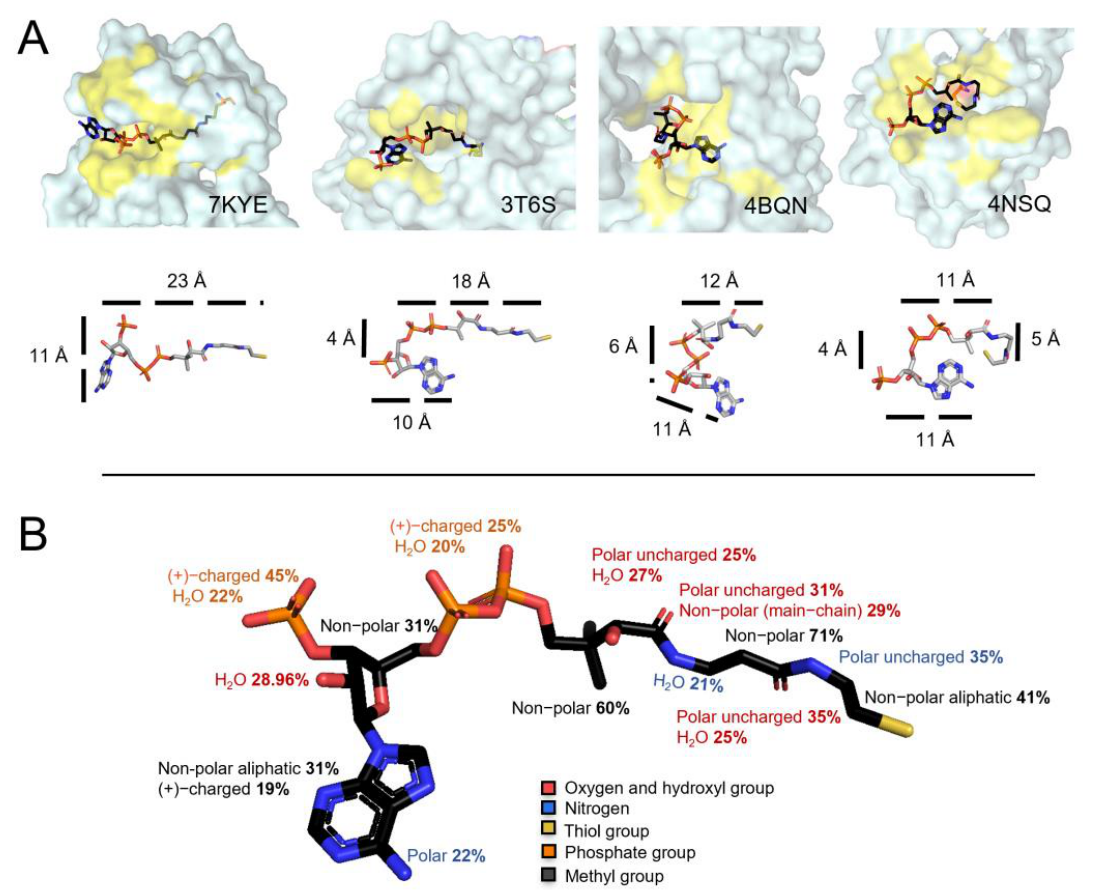
Figure 4. CoA flexibility and stabilization interactions. ( A ) Surface view of four structures showing CoA in different conformations. CoA is colored based on different elements: the Cys residue close to the CoA thiol group is shown in orange and the yellow color represents the location of residues forming stabilizing interactions with CoA. The second row focuses on the CoA structure flexibility and the distances (Å) of its segments. The CoA structure is observed to bend at the diphosphates or at different locations within the pantetheine tail. In an extended form, the CoA tail and the diphosphates are 23 Å, and in a bent form it can be 11 Å in one direction and 5 Å in another. ( B ) CoA–protein stabilization interactions in CoAlated proteins. The types of residues interacting with the different CoA segments are shown (Table S3). CoA is colored based on different elements; phosphate groups are orange, oxygen atoms and hydroxyl groups are red, amino groups are blue and the thiol group is yellow.